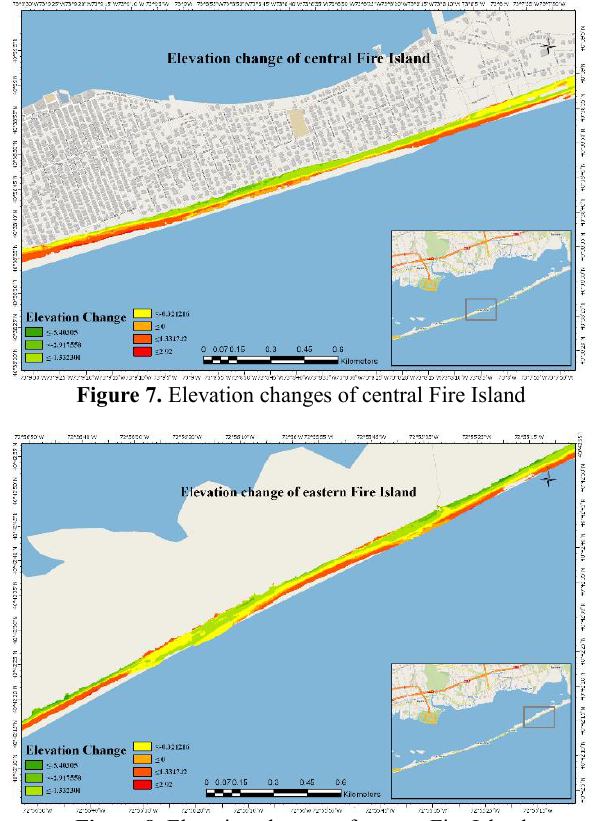
Figure 8. Elevation changes of eastern Fire Island